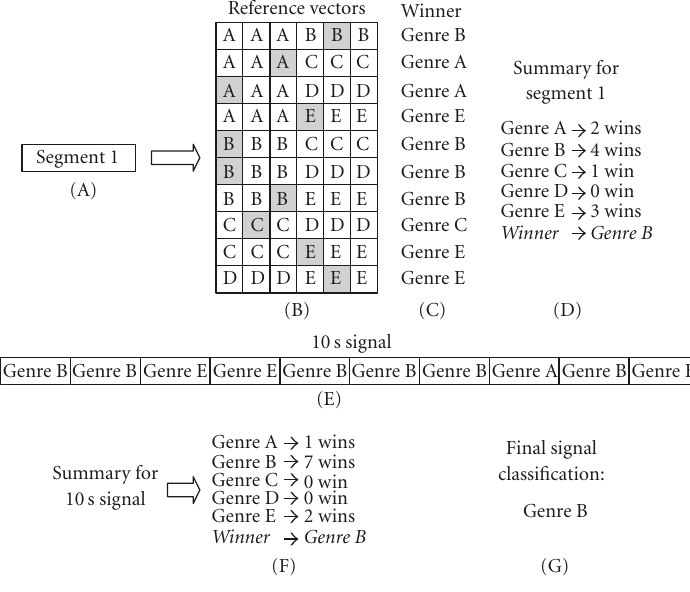
Figure 2: Classification